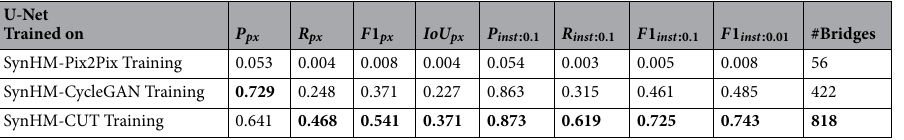
Table 2. Quantitative evaluation of the U-Net models trained on the synthetic historical maps. The synthesize historical maps are produced using style transfer models Pix2Pix, CycleGAN, and CUT, respectively. Results show that CUT outperforms the other two style-transfer models in generating synthetic historical maps for bridge segmentation use. * SynHM stands for synthetic historical map. Significant values are in [bold].